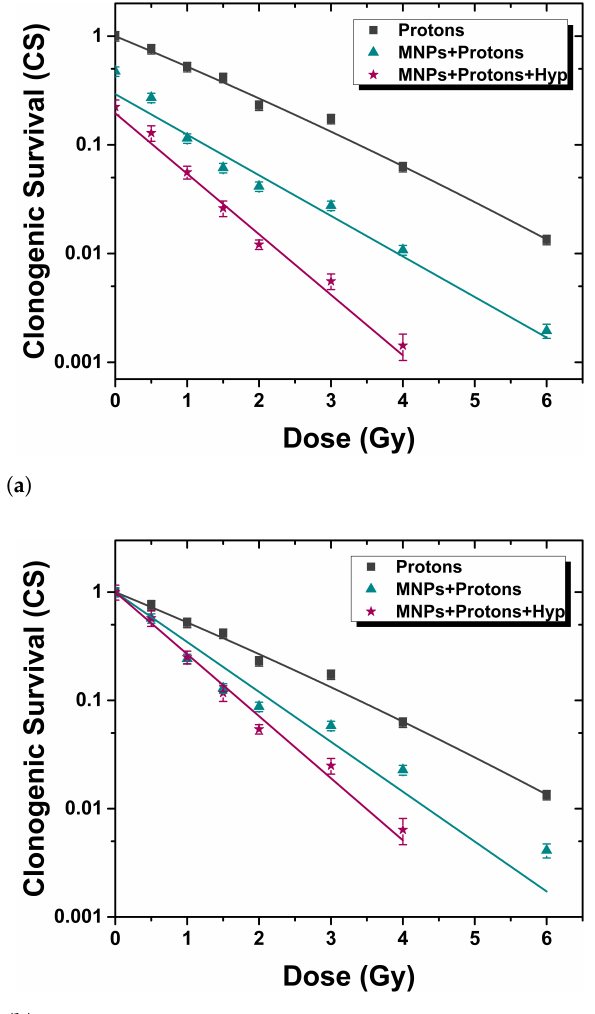
Figure 2. Clonogenic survival of BxPC3 cells culture for three different protocols (see text): Proton therapy (PT) only (gray squares, Mode 1 ), PT+MNPs administration (teal triangles, Mode 2 ) and PT+MNPs administration+Hyp (plum stars, Mode 3 ). A synergistic effect of MNPs and of MNPs+Hyp is noted. ( a ) not normalized curves; ( b ) normalized